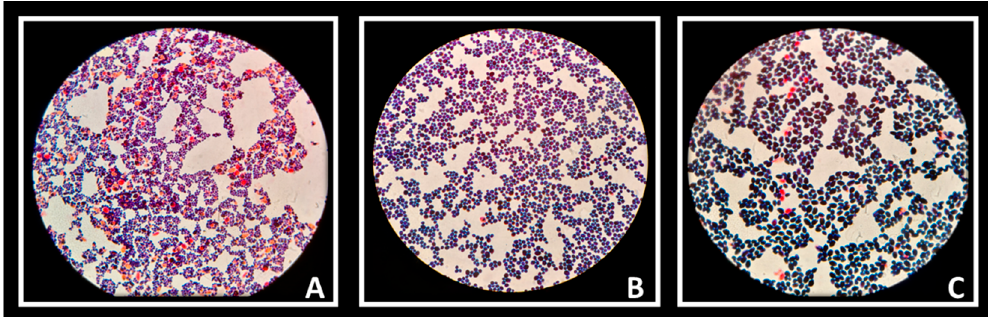
Figure 6. Candida albicans ( A ), C. krusei ( B ) and C. tropicalis ( C ) observed under a microscope (1000×) after Giemsa staining.